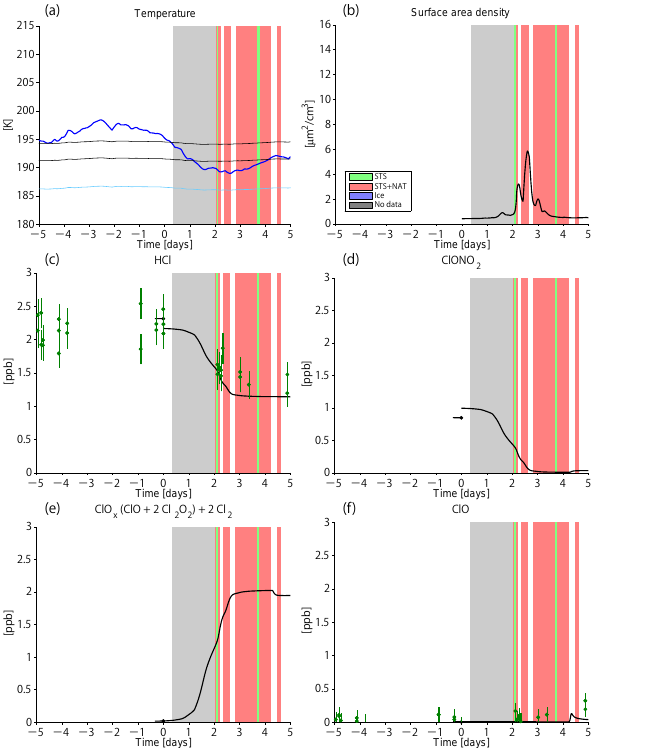
Figure 9. Same as Fig. 8 but for trajectory case no. 05, starting at 17:53:38UT on 30 December 2009 at an altitude of 22.97km. The orange dots in panels (c) – (f) indicate the period of solar illumination when the solar zenith angle is smaller than 90 ◦